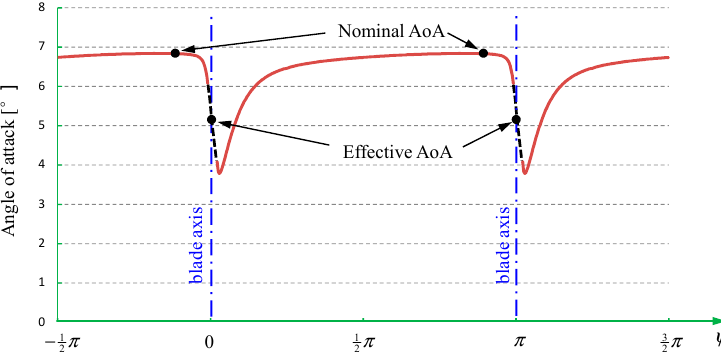
Figure 12. Values of AoA determined by the local velocity after the self-induction subtraction at various